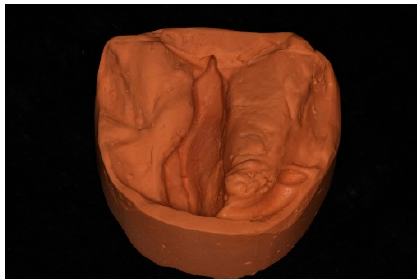
4 Figure 2. The hard and soft cleft palate intraoral defect. Preliminary maxillary and mandibular impressions were made using irreversible hydrocolloid material (BluePrint ® X-creme; Dentsply Int, York, PA, USA) and the obtained casts were used for the fabrication of maxillary and mandibular custom trays. A modeling impression compound (Green stick impression compound; Kerr Corp., Brea, CA, USA) was used to bor- der-mold the basal area of the tray (Figure 3) and the hard palate cleft de- fect, whereas the final wash was performed using a polysulfide impression material (Permlastic; Kerr Corp) (Figure 4). The undercuts in the maxillary master (Figure 5) cast were blocked-out with baseplate wax, and the max- illary record base was fabricated. For the mandibular final impression, the vertical and centric relation records, the set up of the teeth, the try-in pro- cedures, and the laboratory steps, techniques and guidelines used in the fabrication of conventional complete dentures were followed. The maxil- lary obturator prosthesis was processed, placed intraorally, and the neces- sary adjustments were made. In order to record the contours of the velopharyngeal musculature and to add the pharyngeal extension of the prosthesis, functional tracing, with a resilient acrylic relining material (Trusoft; Hary J. Bosworth Co., Skokie, IL, USA), was performed. The con- tours of the defect were functionally recorded while the patient swallowed, spoke, made a circular head movement, and breathed over a 20-minute pe-